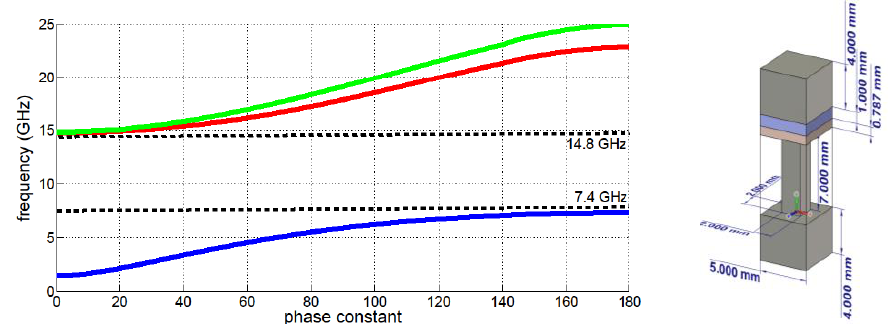
Figure 2. Periodic cell for the bed of nails and calculated dispersion diagram for the array of